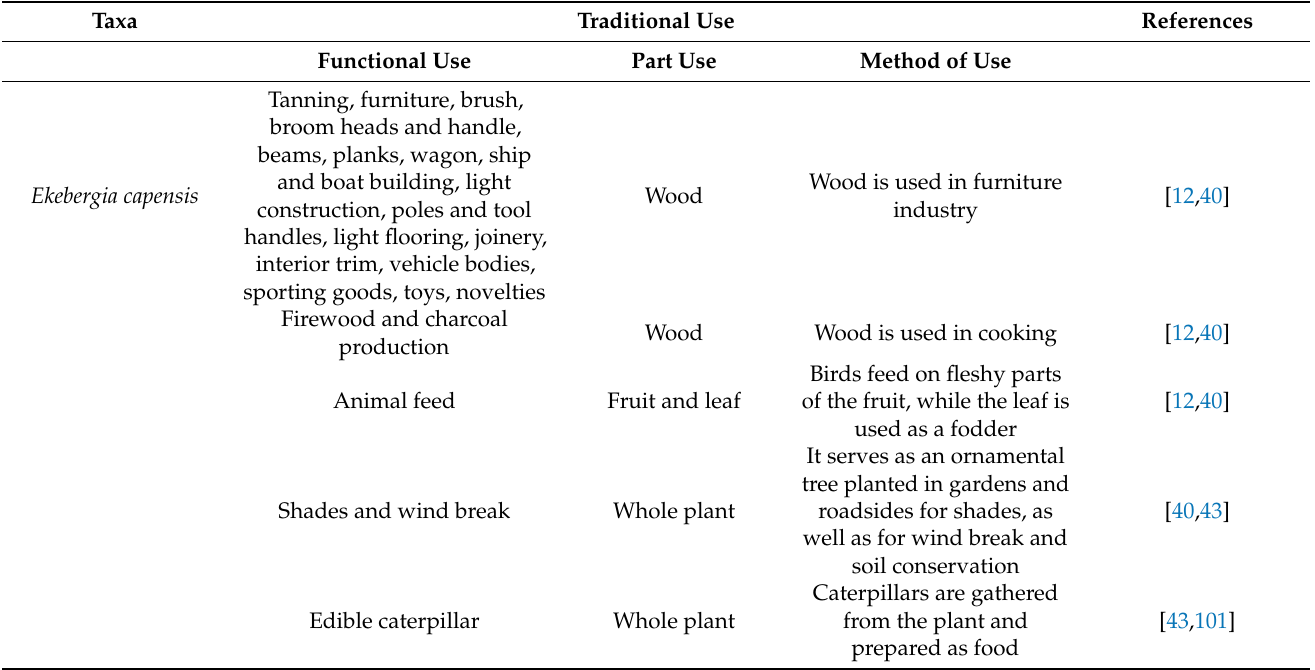
Table 2. The functional uses of South African